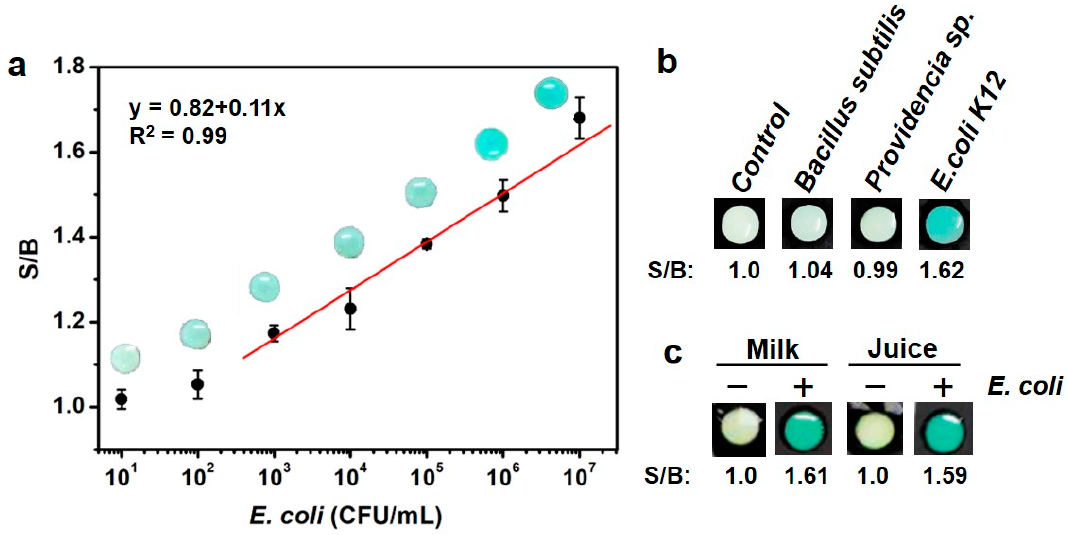
Figure 4. ( a ) Plot demonstrating linear correlation between Signal-to-background (S / B) ratio and concentration of E. coli over the range of 10 3 –10 7 CFU · mL − 1 . Each datum is the average of three measurements, and the error bar is the standard deviation. ( b ) Specificity of the device. ( c ) Detection of E. coli in the presence of complex sample matrices represented by orange juice and milk. Control: sample with pure reaction bu ff er. “ + ”: 10 7 E. coli cells added to a test sample. “ − ”: a test sample without E. coli cells. Photographs were taken after a signal-producing time of 1